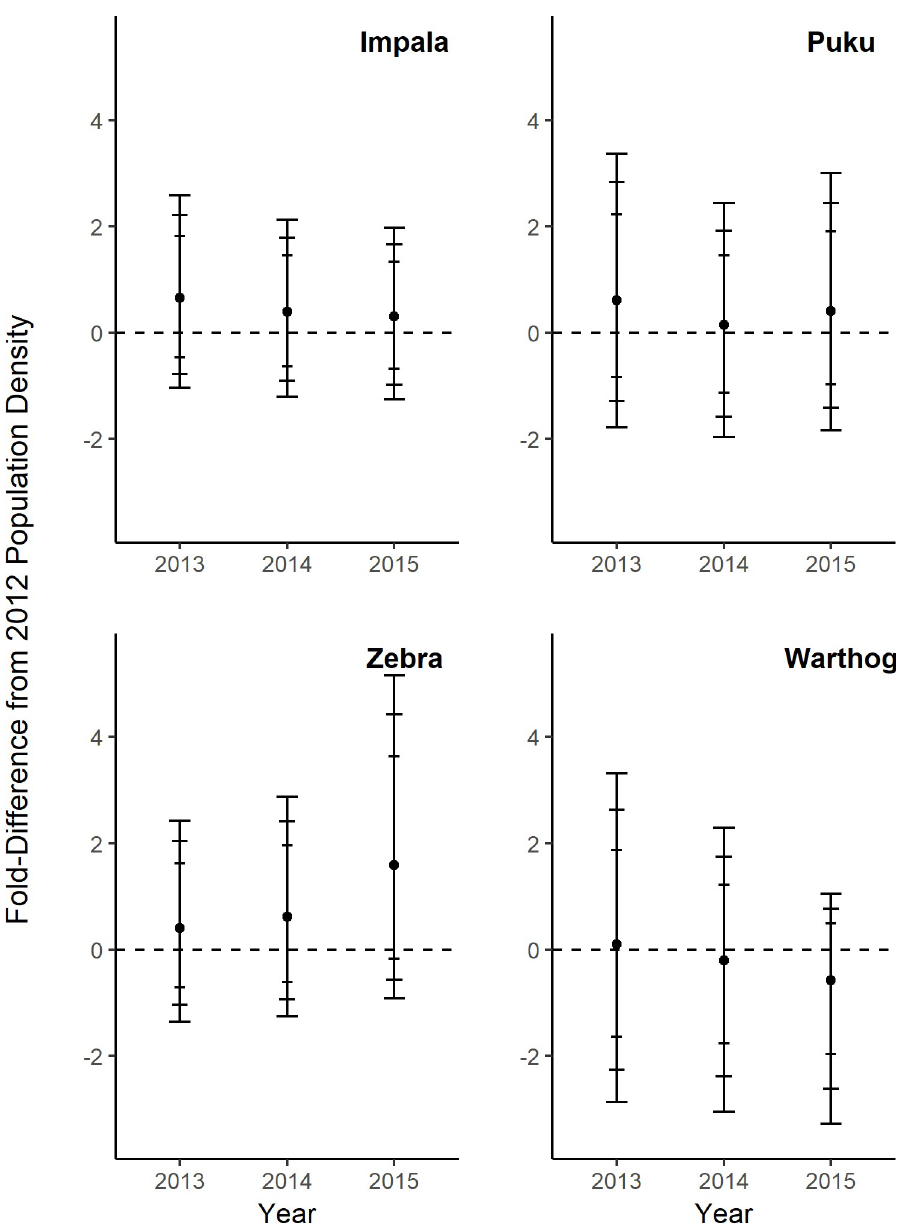
Fig 4. Differences in population density estimates through the study period and 2012 density estimates (dotted line), with other covariates held constant. Error bars indicate 80%, 90%, and 95% confidence limits. densities in western parklands were not detectably different from the GMA. Predicted zebra densities were 5-fold and 12-fold greater in the eastern parklands and western parklands, respectively, with high confidence that a protection effect existed for both comparisons. Pre- dicted warthog densities were higher in protected regions compared to the GMA, but CIs overlapped predicted GMA densities. Throughout the study period we could not detect any density trends for any species after controlling for other covariates (Fig 4), including during the trophy hunting moratorium (2013–2014).